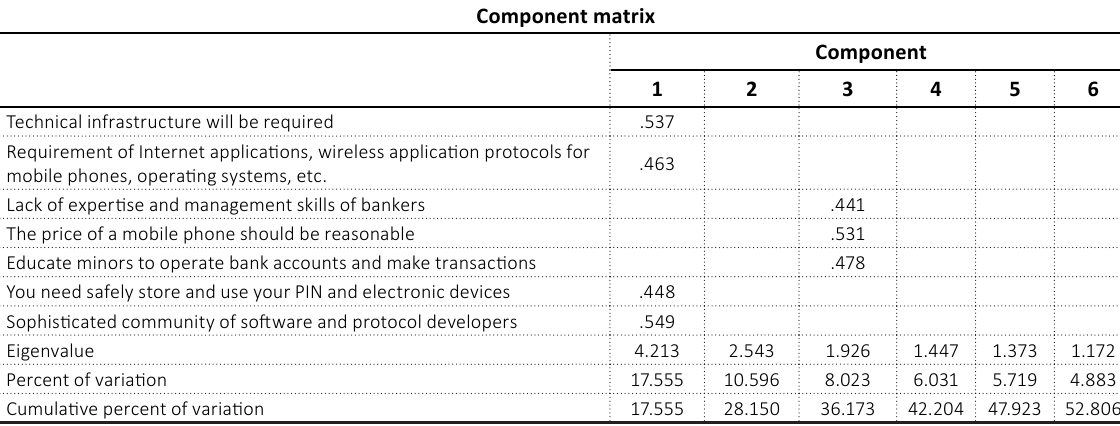
Table A2 (cont.). Challenges of instigating full-fledged e-money in